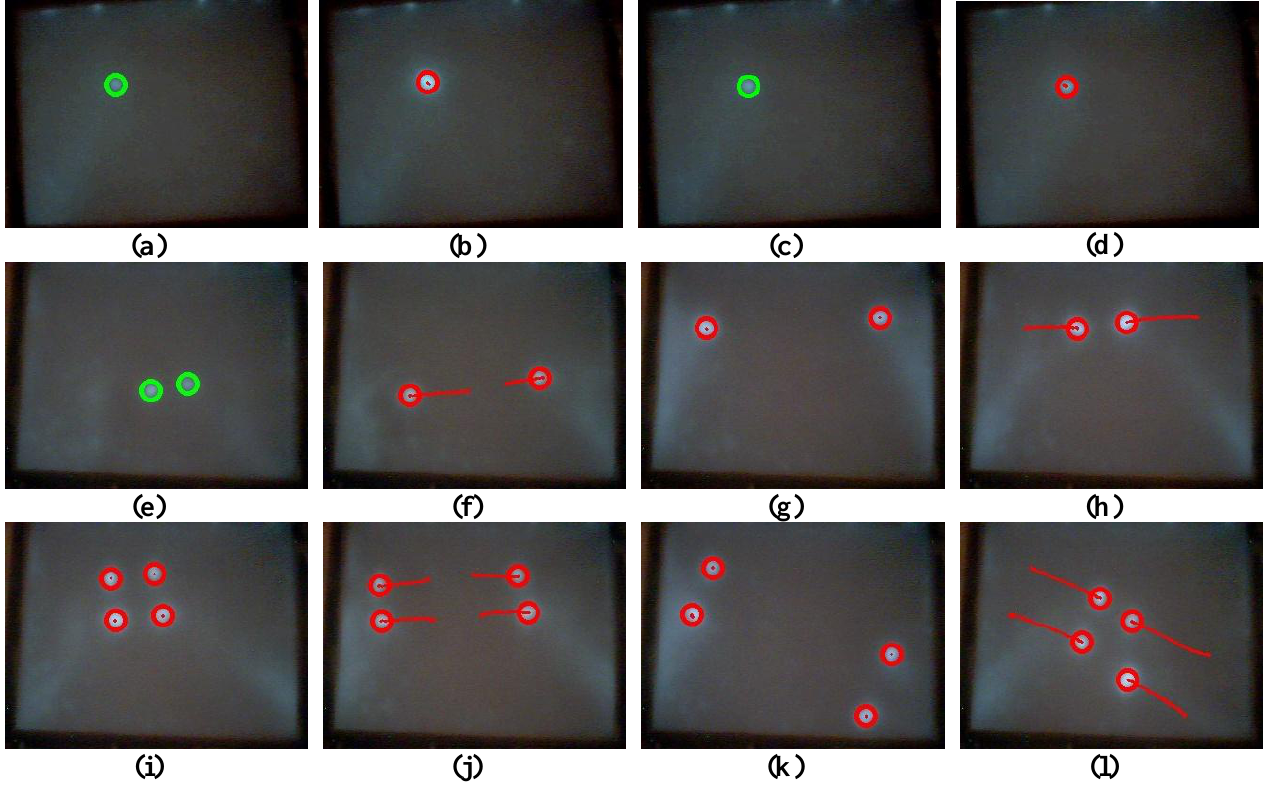
Figure 14. Touch finger detection and tracking results of the proposed system in Test sequence 4. (a) 168 th frame. (b) 170 th frame. (c) 174 th frame. (d) 178 th frame. (e) 216 th frame. (f) 267 th frame. (g) 476 th frame. (h) 535 th frame. (i) 861 st frame. (j) 902 nd frame. (k) 808 th frame. (l) 855 th frame.